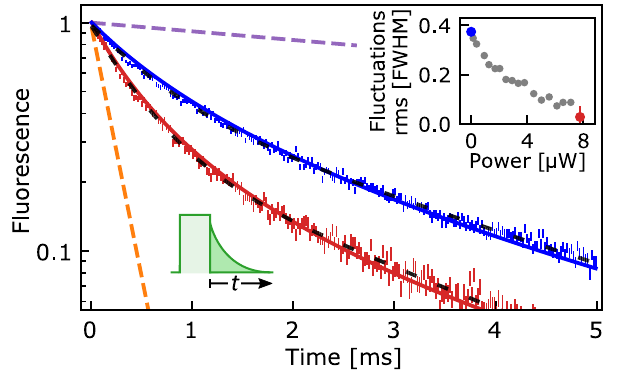
FIG. 2. Purcell-enhanced emission. After pulsed excitation with a power of 54 nW and a duration of 0 . 5 μ s, the fluorescence of resonator-coupled dopants (blue) decays on a faster timescale than in free space (purple dashed line). The decay rate is further enhanced when the cavity is kept on resonance via photothermal feedback (red). In both cases, the decay is well fit by a biexponential curve (black dashed), and in excellent agreement with a numerical modeling of the resonator with no free parameters (red and blue solid curves). According to this model, the decay of dopants at the field maximum (orange dashed line) corresponds to a lifetime-reduction factor of 59(6). The inset shows the fluctuations of the cavity length as a function of feedback laser power, derived by fitting the measured decay to our model.